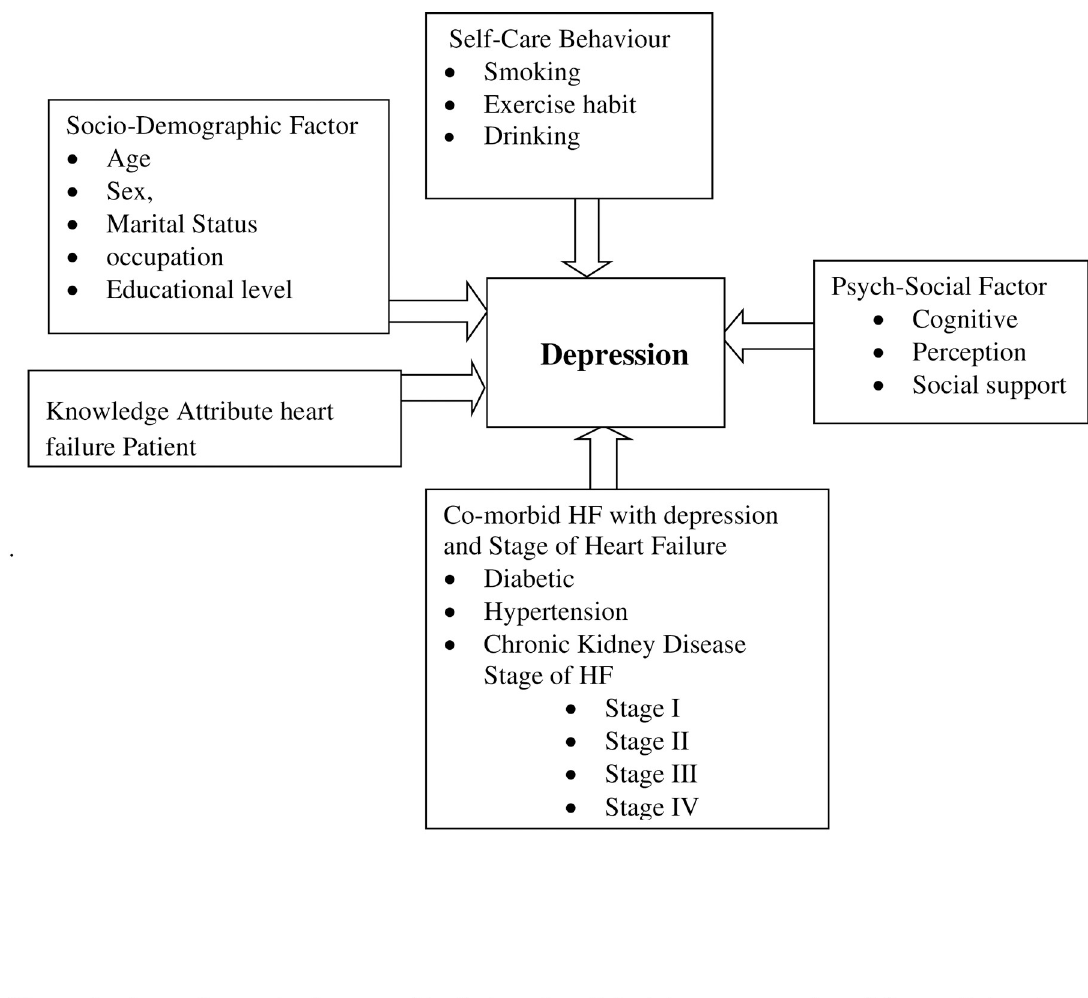
Fig 1. Conceptual framework for assessment of prevalence and associated factors of depression among heart failure patients at cardiac follow-up clinic.